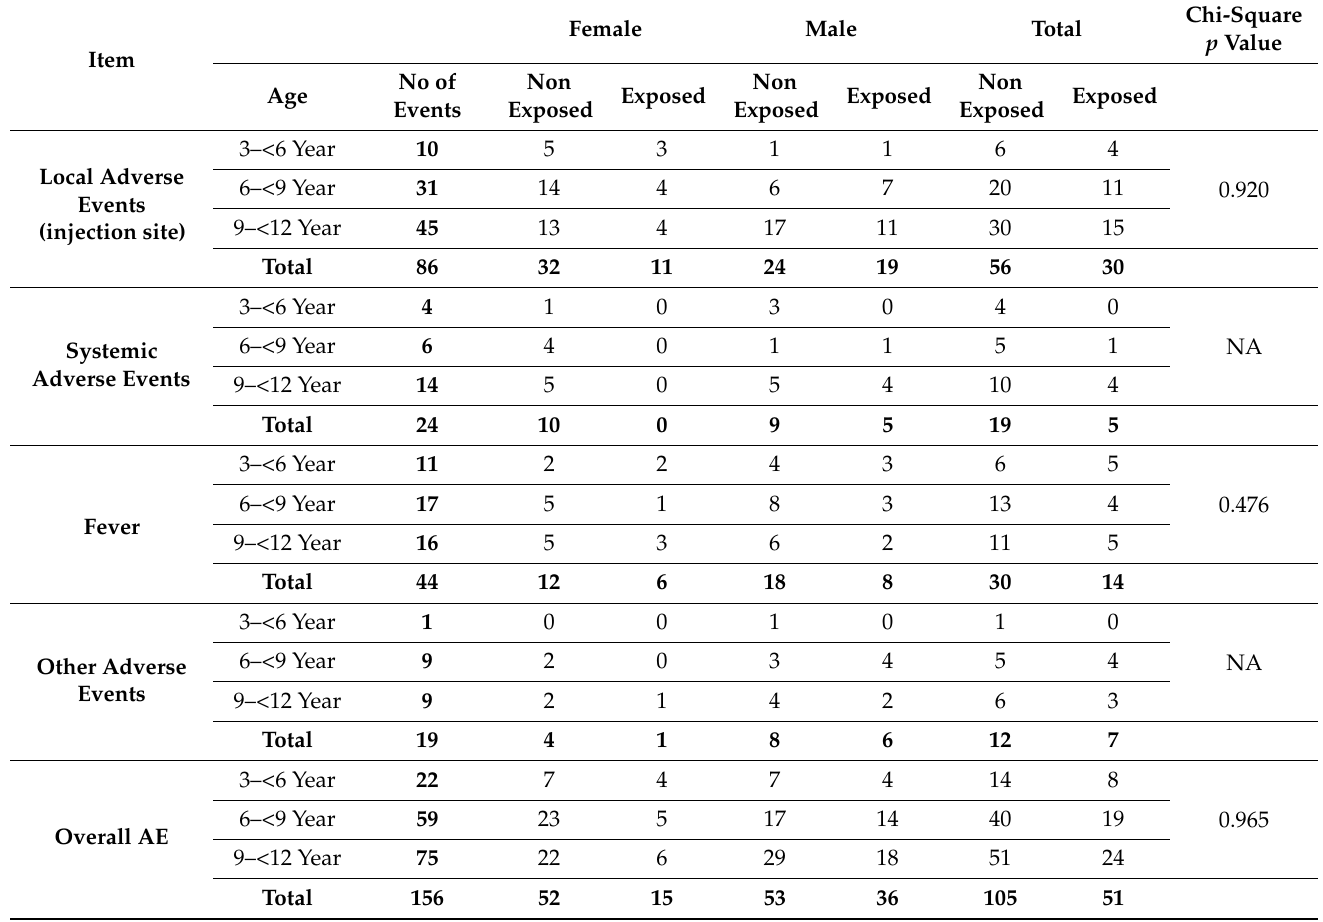
Table 4. Comparison of the adverse events with